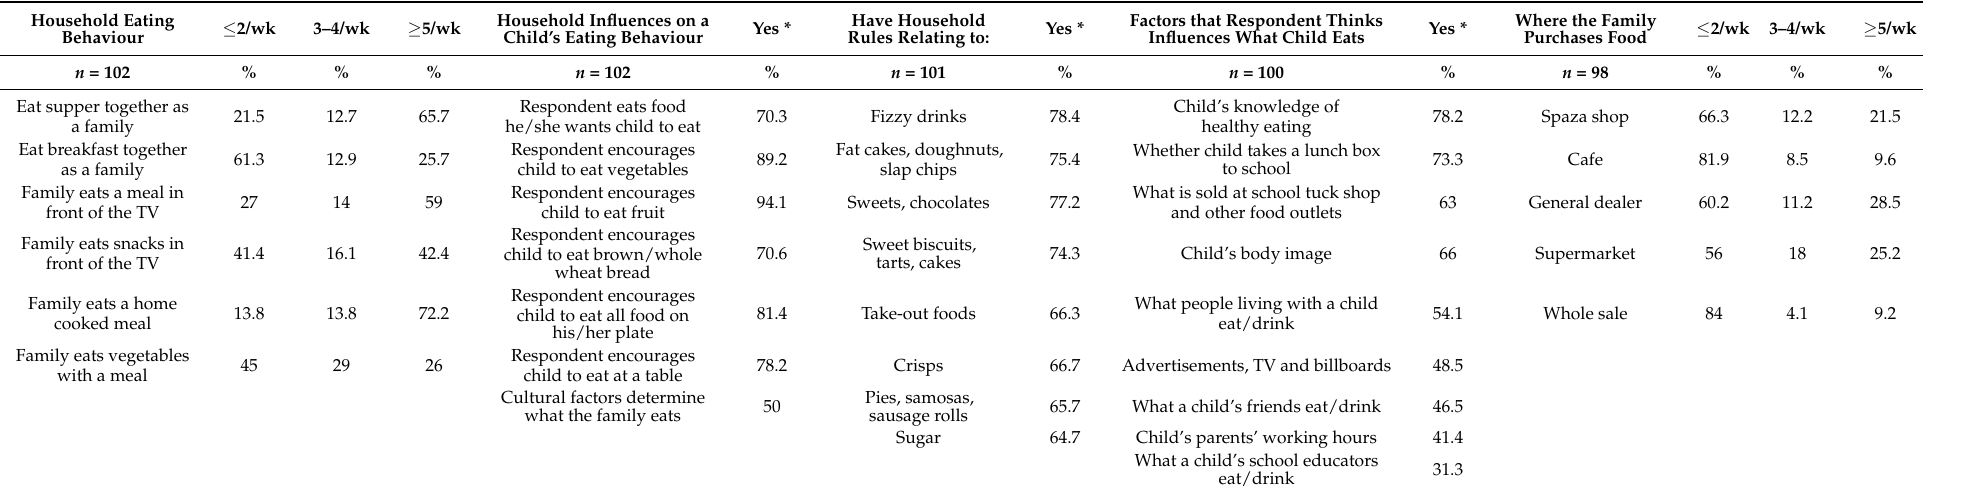
Table 2. Household eating and food purchasing behaviour as reported by the household